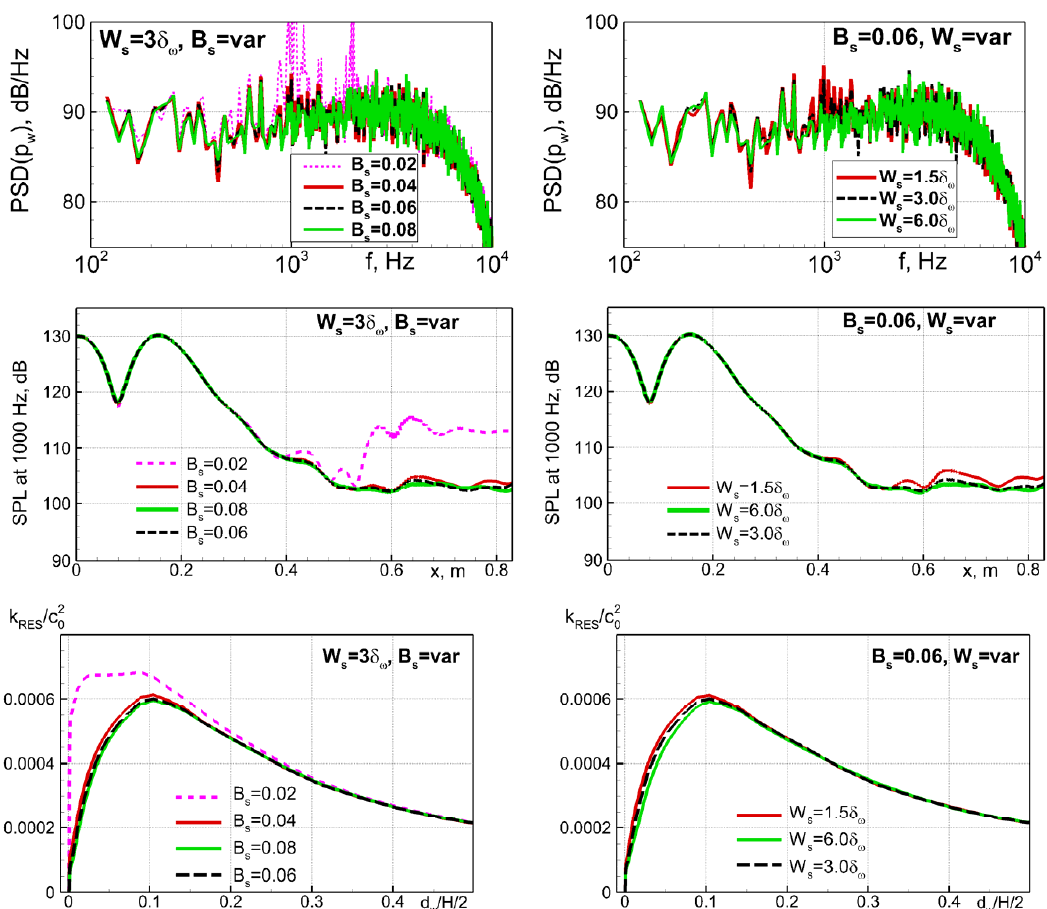
Figure 21. Sensitivity of predictions of NASA GIT flow at f e = 1000 Hz to parameters B s and W s of stabilization body force (10). Upper row: spectra of wall-pressure fluctuations at x = 0.6 m; mid row: SPL at the lower wall; lower row: profiles of resolved TKE at x = 0.6 m.